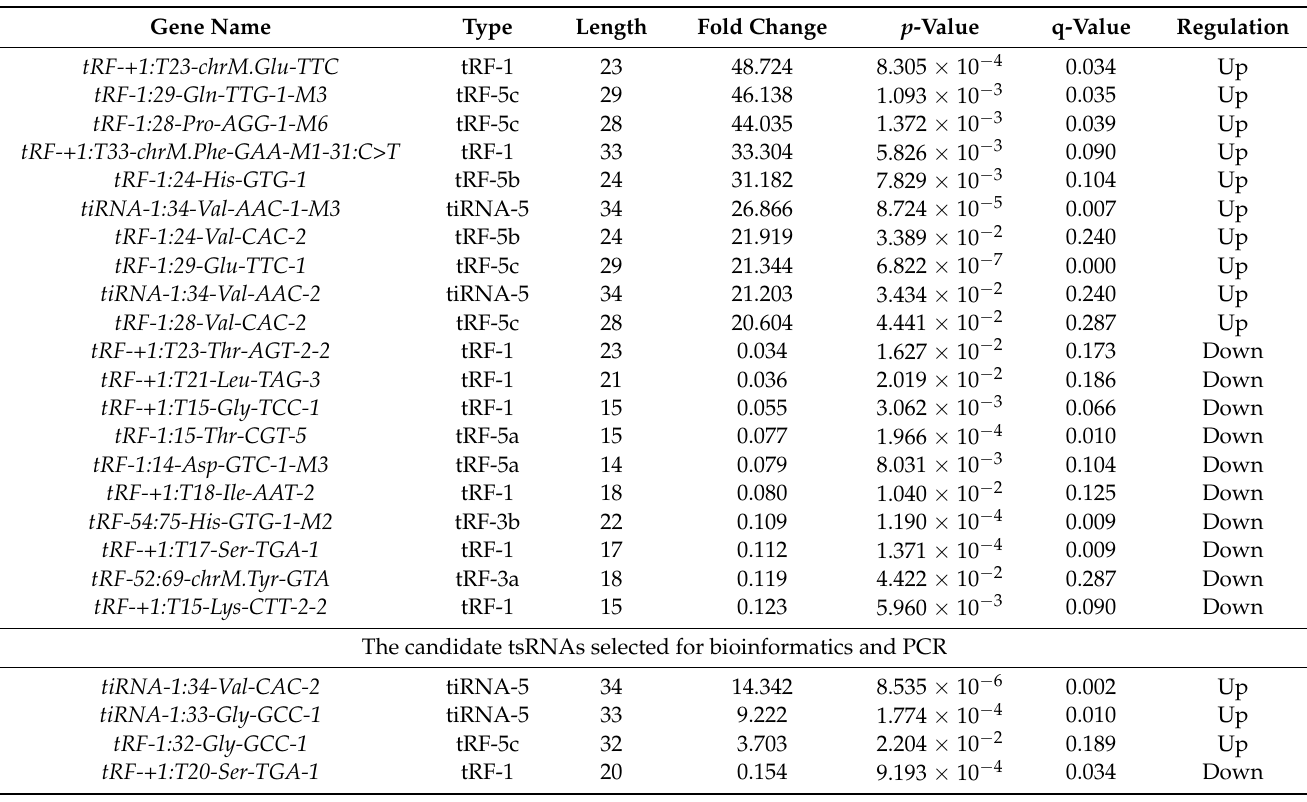
Table 2. The top 10 upregulated and downregulated tsRNAs ranked by fold changes (T vs.